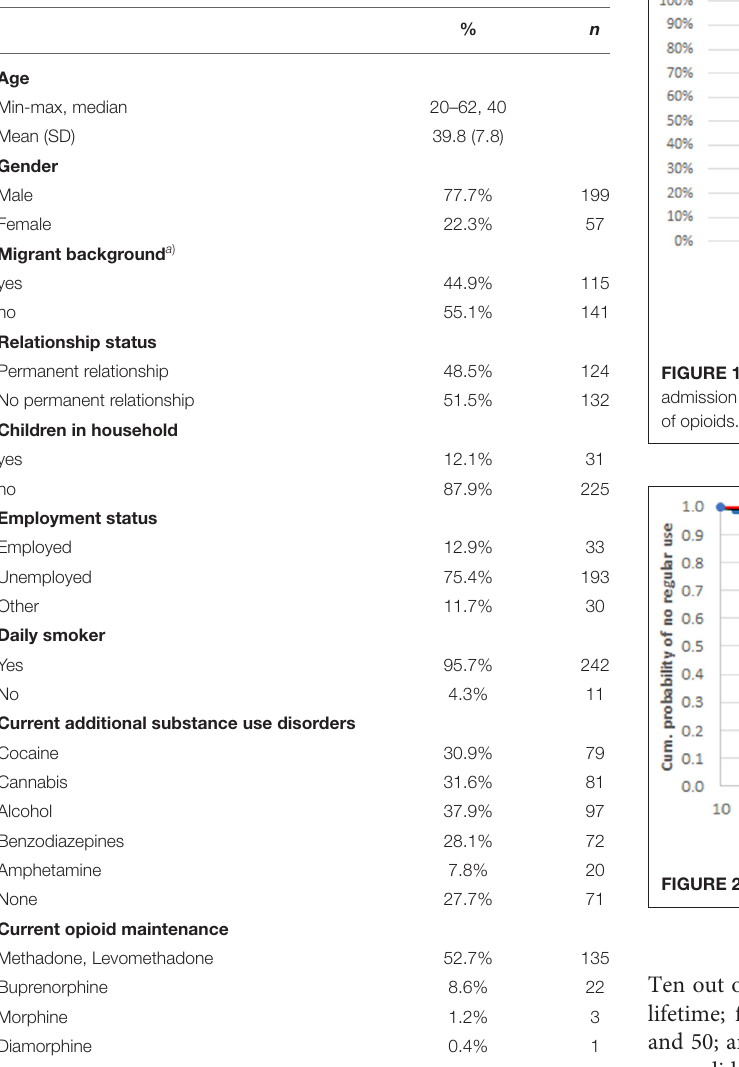
TABLE 1 | Sample characteristics.